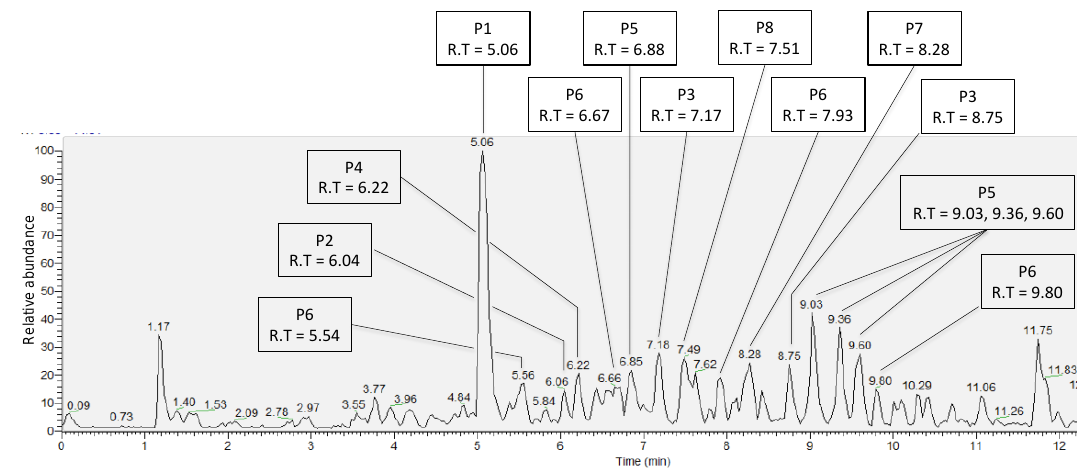
Figure 5. Positive ionisation mode chromatogram of SOA generated from the ozonolysis of α -phellandrene (experiment 9). Major positive mode ionisation peaks detected across all experiments (Table 3) are labelled.